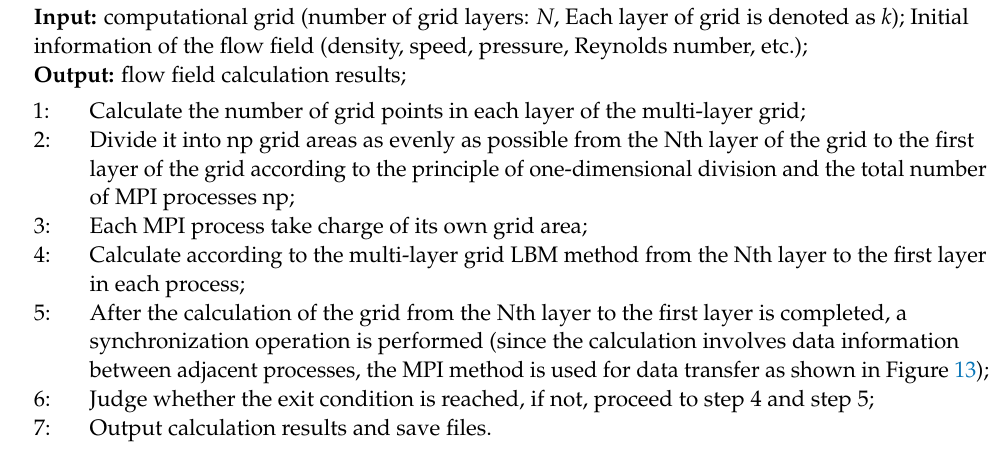
Algorithm 2 Multi-layer grid LBM parallel algorithm based on